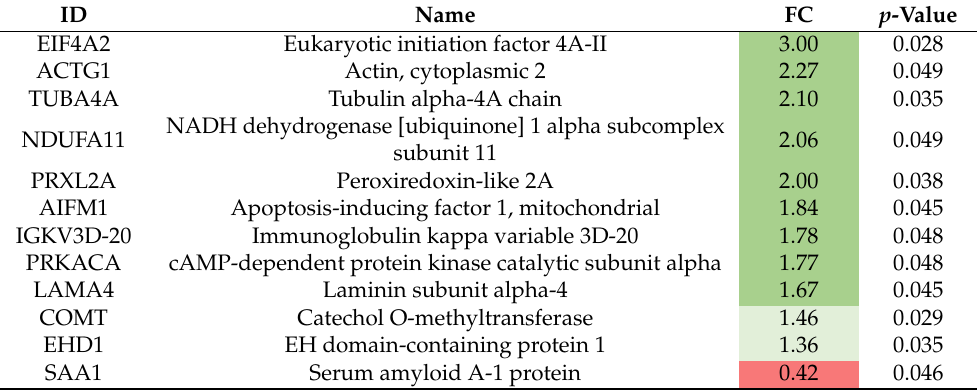
Table 2. List of significantly regulated proteins between HFpEF vs. non-HFpEF samples. Fold change (FC) values are depicted as red (FC ≤ 0.67) or green (FC ≥ 1.5, dark green if FC ≥ 1.5). Only proteins with a p -value ≤ 0.05 were considered for